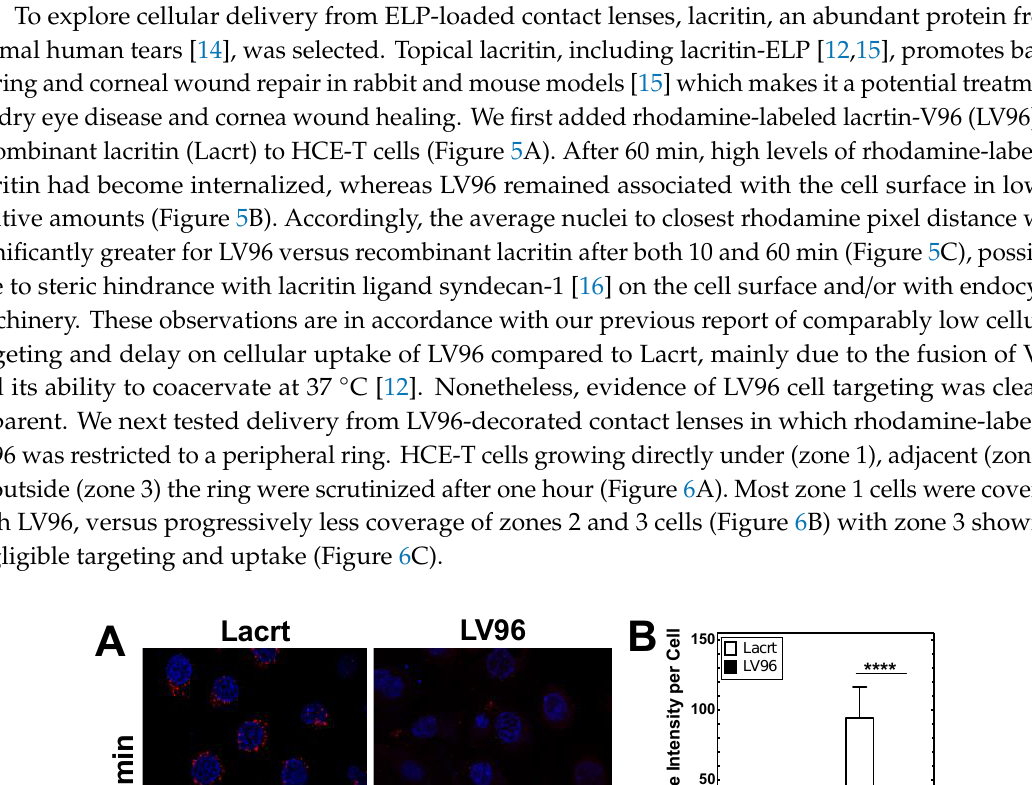
8 of 13 Figure 4. ELP retention on Proclear Compatibles TM lenses depends on ELP T t and incubation temperature. ( A ) Release profiles of group 1 (V96_37 °C → 37 °C), group 2 (V96_37 °C → 4 °C), and group 3 (V96_4 °C → 4 °C) were shown. ( B ) Release profiles of group 4 (S96_37 °C → 37 °C) and group 5 (V96_4 °C → 4 °C) were shown. Small aliquots of the incubation solution were sampled over